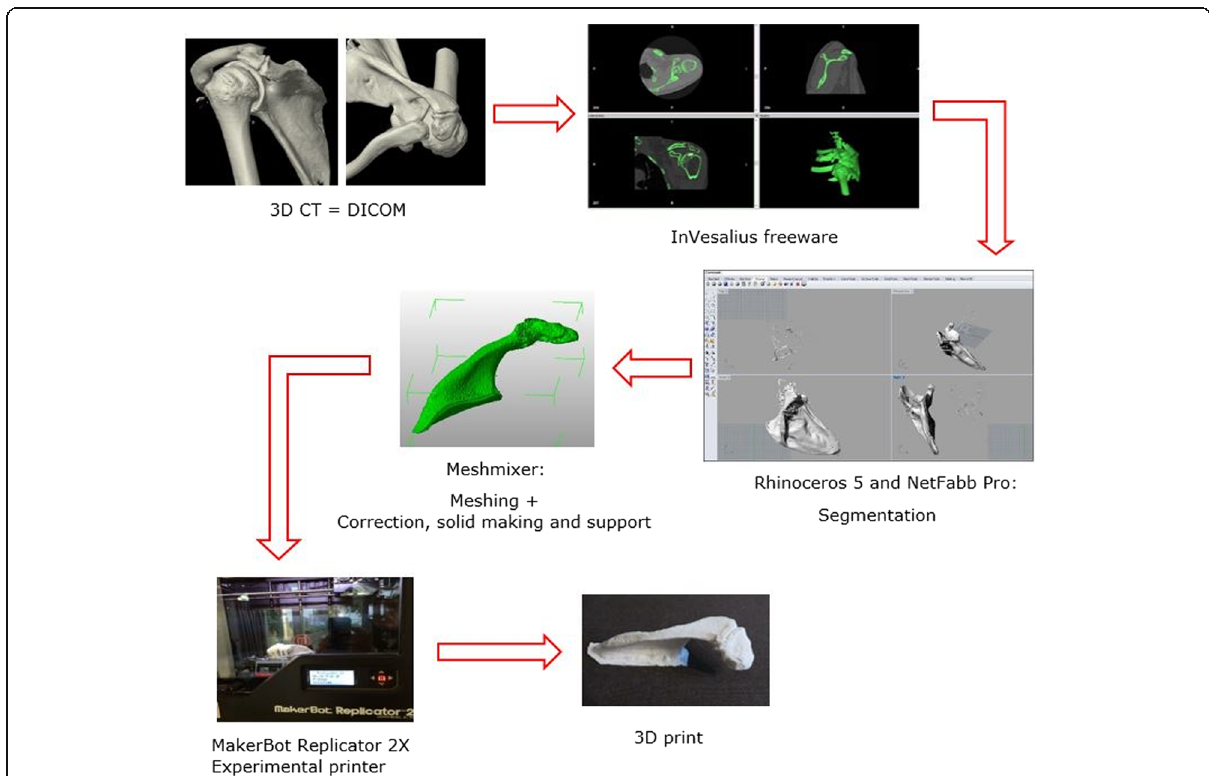
Fig. 1 Process of 3D printing. A 3D CT scan (DICOM file) was converted into a file the printer could recognise using InVesalius freeware. Rhinoceros 5 and Netfabb Pro were used to segment the desired area of interest, after which Meshmixer was used to extract a surface from this area (meshing) and for further processing of the image (correction, solid assembly and support). A 3D print was made using the MakerBot